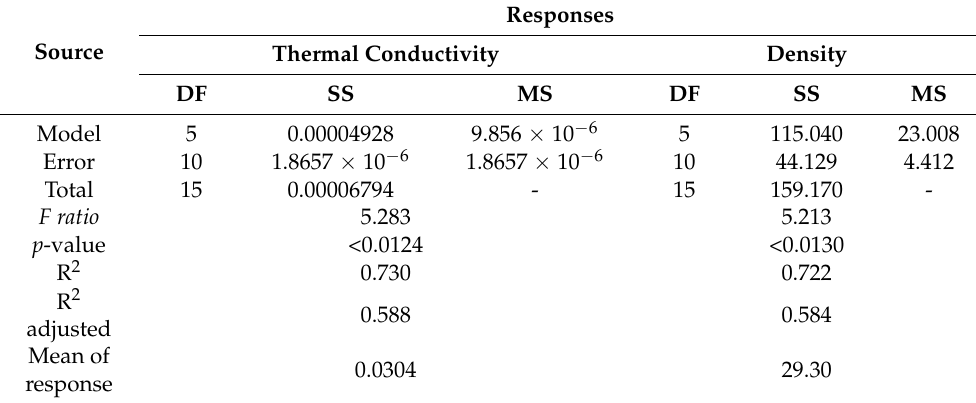
Table 3. ANOVA results for the reduced regression models for thermal conductivity and density.